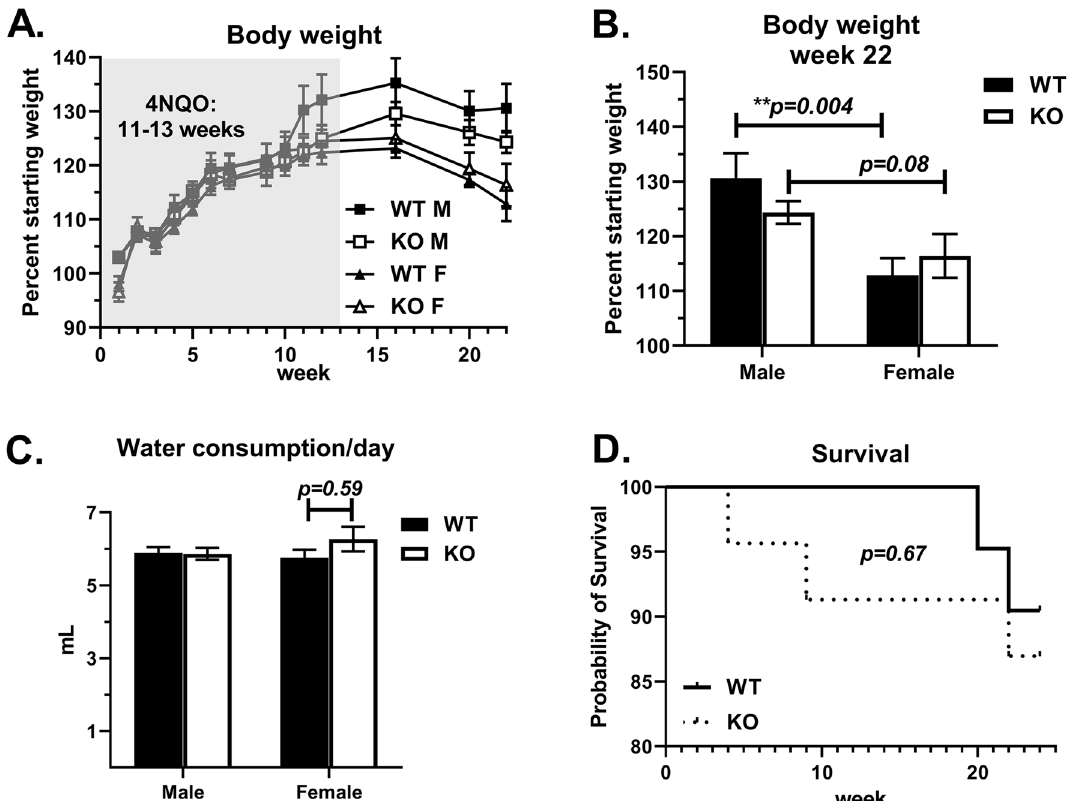
Figure 1. Endogenous GPR68 expression does not significantly affect body weight, water consumption or survival following oral 4-Nitroquinoline N-oxide (4NQO) treatment. WT (closed symbols) and KO (open symbols) mice were separated into male (M) and female (F) groups and placed on 4NQO drinking water (0.05 mg/mL) for 11–13 weeks, followed by normal water for 11–12 weeks. ( A ) Body weight reported as a percent of starting weight (week 0 = 100%) at the indicated timepoints. Area under the curve analysis revealed no differences between the groups. ( B ) Body weight at week 22. ( C ) Average amount of 4NQO water consumed per mouse each day. Water was replaced each week, with the volume consumed divided by the number of mice in each cage. This number was then divided by the days since the last water change. ( D ) Time course showing the percent of WT (solid line) or KO (dotted line) mice surviving at each weekly timepoint. Data are combined from three independent experiments and shown as the mean +/− SEM (WT M n = 9; WT F n = 10; KO M n = 11, KO F n = 9). Asterisks indicate statistically significant differences between the groups (** P < 0.01).